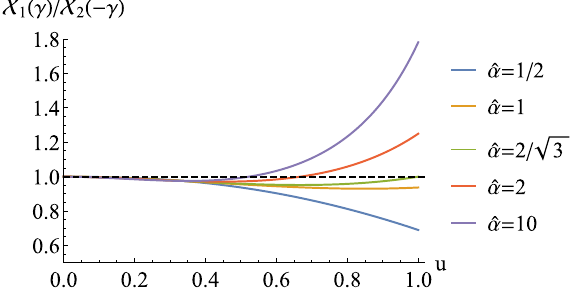
Fig. 12 X 1 (γ)/ X 2 ( − γ) as the function of u with different ˆ α . Here we set γ = 1 /